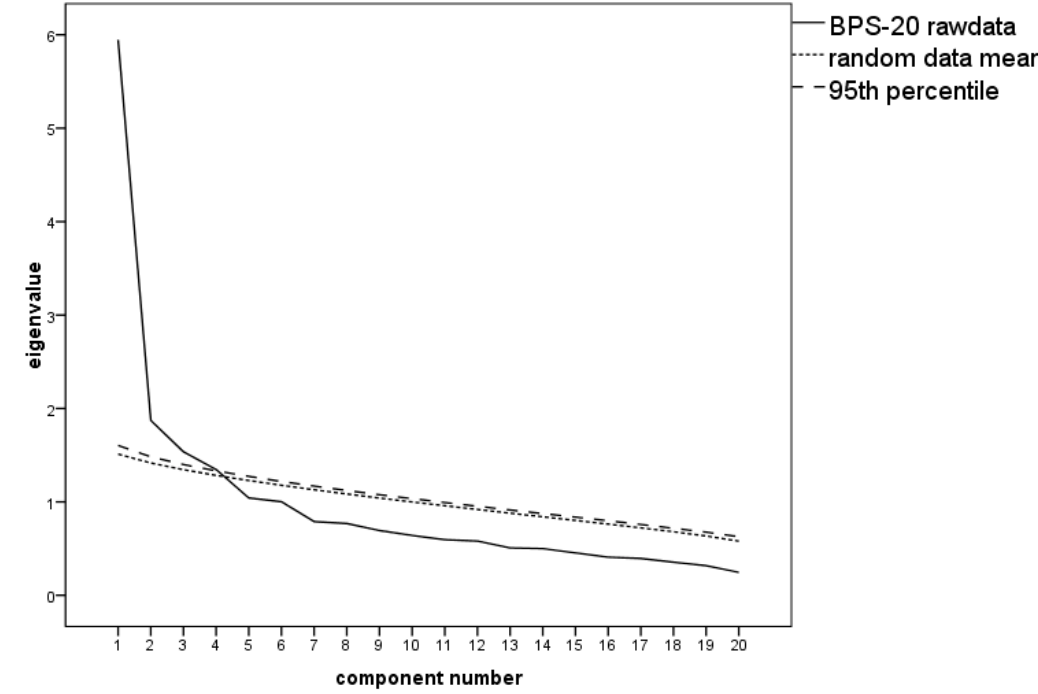
Figure 1. Scree plot with the parallel analysis of the Boredom Proneness Scale (BPS-20) suggesting three factors to be extracted.